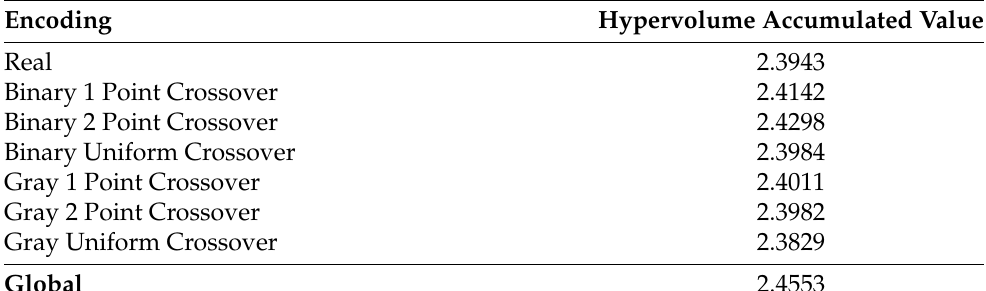
Table 8. Maximum accumulated Hypervolume value (encoding experiment).